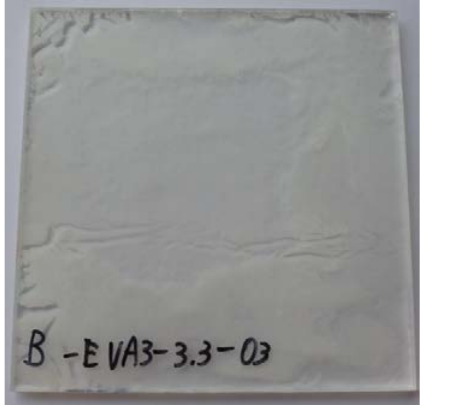
Fig. 25 Paint not sticking to the glass (here smooth glass)